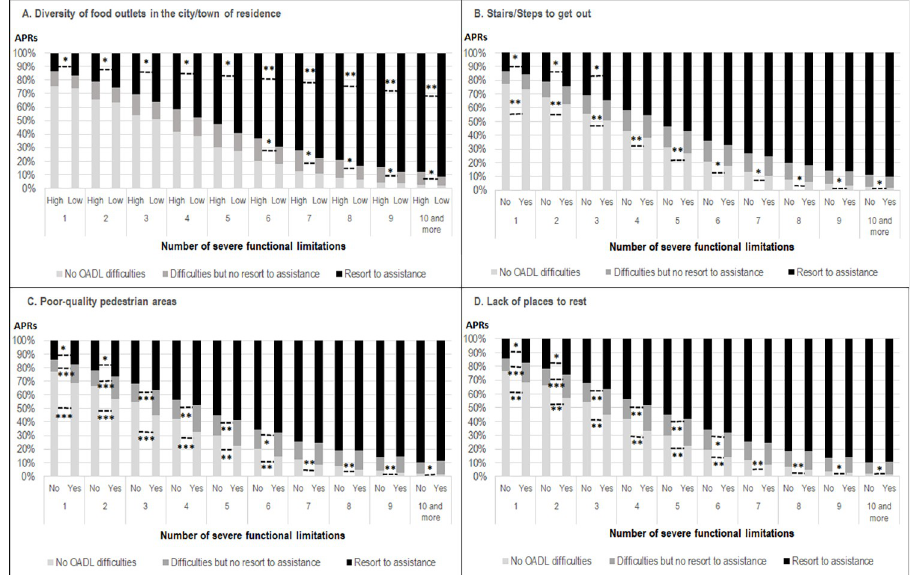
Fig 1. Adjusted Predictions at Representative values˚ (APRs) of OADL difficulties and resort to assistance, from 1 to 10+ severe FLs (Model 2): (A) high vs low diversity of food outlets in the city/town of residence; (B) with/without stairs/steps to get out; (C) with/without poor-quality pedestrian areas; (D) with/without places to have a rest. CARE-Seniors Me´nages Survey (60+ with at least 1 FL) 2015, France. � p < 0,10; �� p < 0,05; ��� p < 0,01. ˚Adjusted on gender, age as a continuous variable, level of education, living alone, frequency of relationships with family members (other than co-residents), with friends and neighbours, number of diagnosed chronic diseases, psychological distress, number of severe functional limitations and all the environmental barriers. � p-values were used to test whether the differences (MERVs) between the predicted probabilities (APRs) were significantly different from 0.